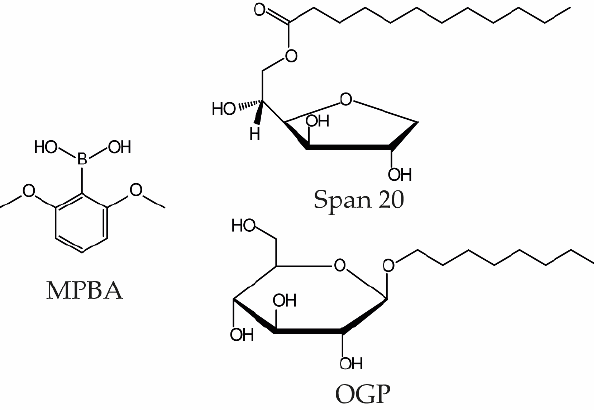
Figure 1. Molecular structure of MPBA, Span 20, and OGP.